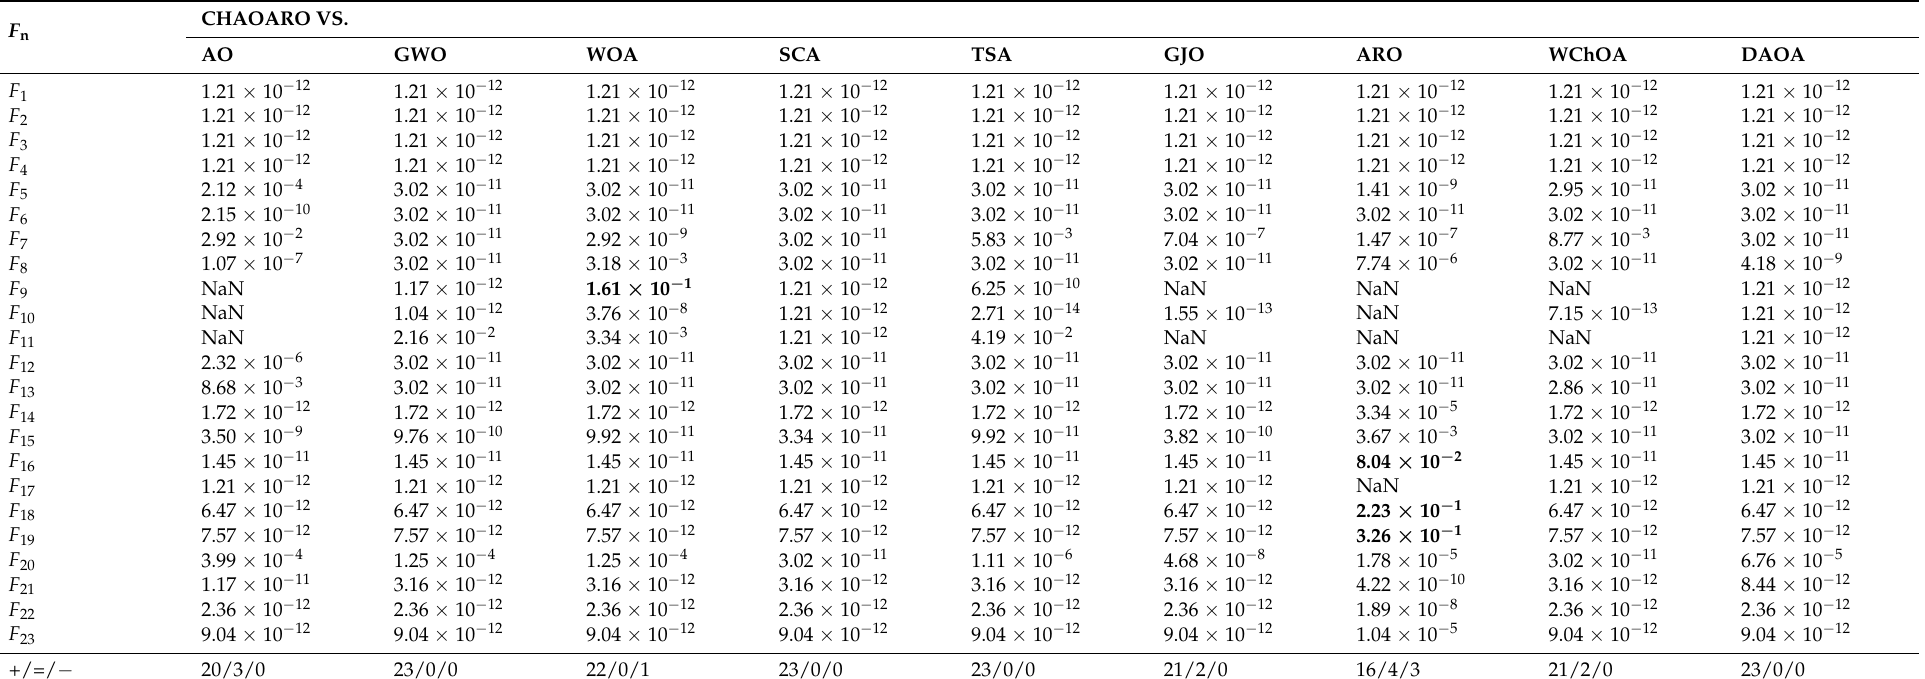
Table 7. Statistical results of Wilcoxon rank-sum test for different algorithms on 23 benchmark